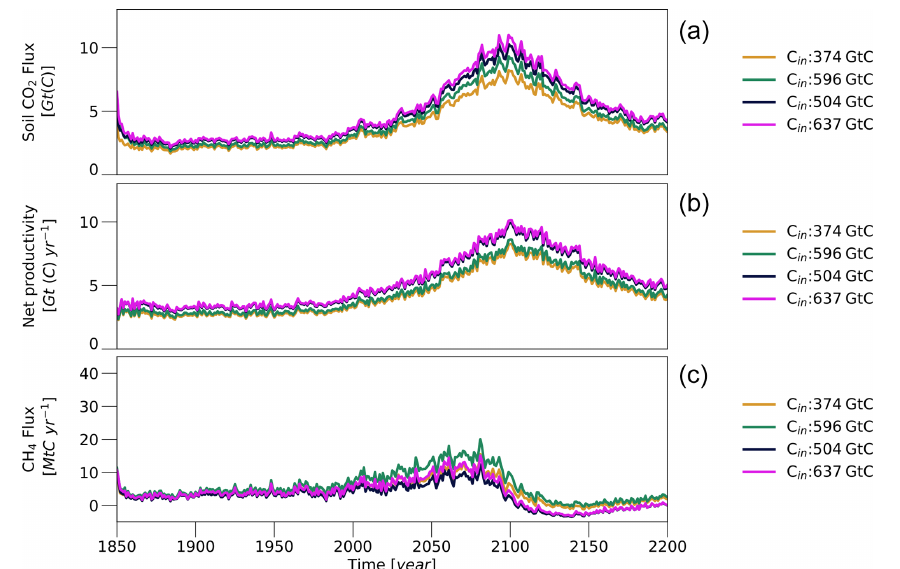
Figure A3. Initial carbon pools. (a) Soil CO 2 fluxes in permafrost-affected regions simulated with different initial soil carbon concentrations and soil depths. (b) Same as (a) but for net primary productivity. (c) Same as (a) but for methane emissions. Yellow lines show simulations that were initialized with the observed soil organic matter that can be contained in the soil when using standard-soil depths, roughly 636GtC in regions that in reality are affected by continuous, discontinuous and sporadic permafrost and 374GtC in those regions in which the model simulations show near-surface permafrost in the year 2000. Green lines show simulations in which the carbon pools were scaled to be closer to the observed soil organic matter – roughly 1000GtC. Here, the simulations were initialized with 858GtC in the observed and 596GtC in the simulated permafrost regions. Dark-blue lines show simulations that were initialized with the observed soil organic matter concentrations but with increased soil depths in the model; these simulations are initialized with 797GtC in the observed and 504GtC in the simulated permafrost regions. Magenta lines show simulations with both increased soils depths and upscaled initial soil carbon pools; these simulations are initialized with 931GtC in the observed and 637GtC in the simulated permafrost